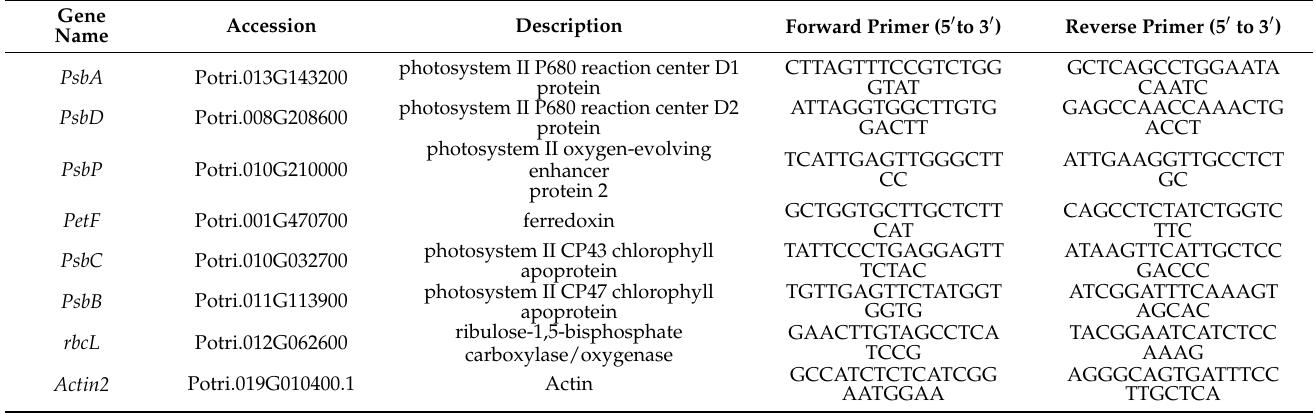
Table 4. Specific primers used in relative